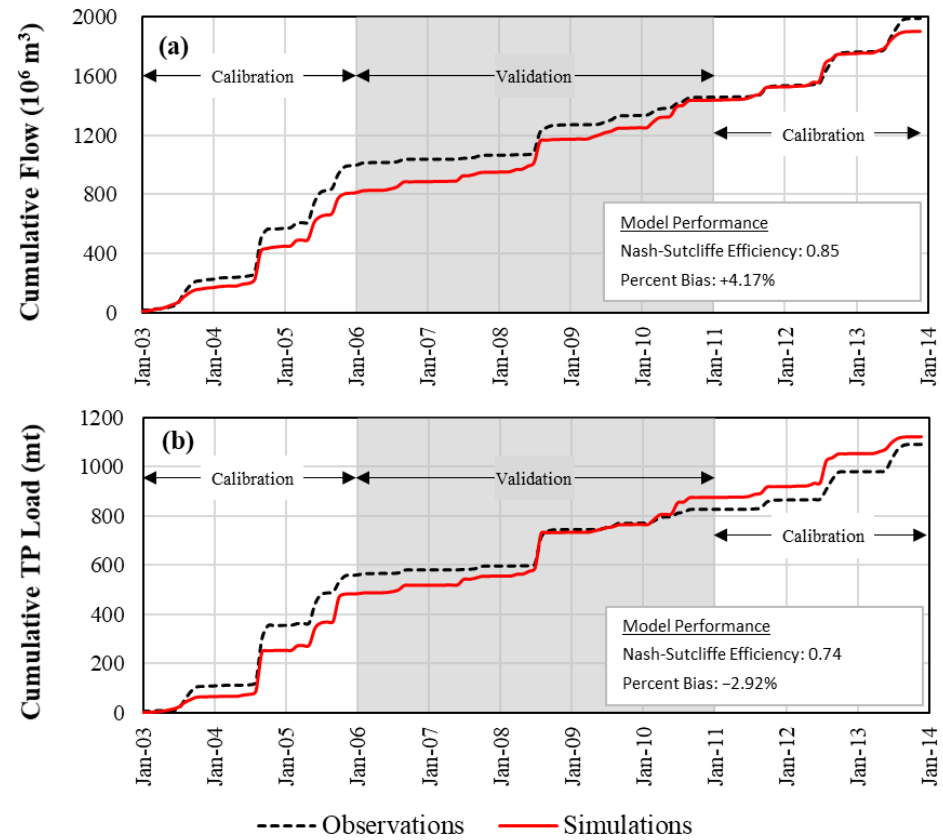
Figure 2. Watershed Assessment Model (WAM) performance over the calibration–validation period (2003–2013) in simulating the TCNS wide ( a ) flows and ( b ) TP